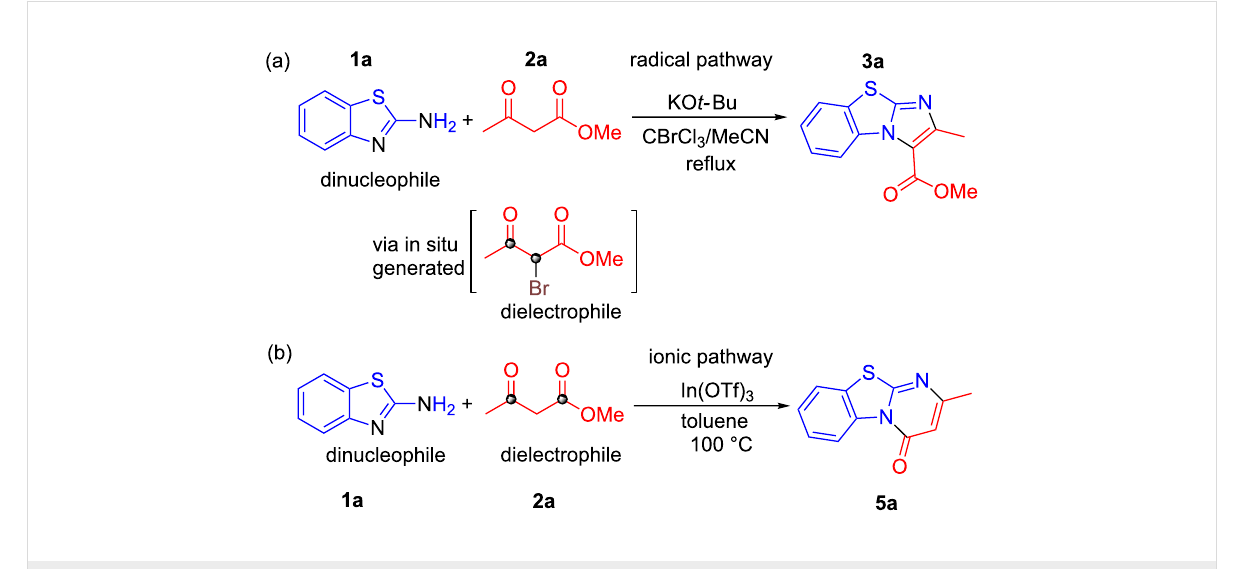
Scheme 1: Two different intermolecular cyclization pathways controlled by reagents